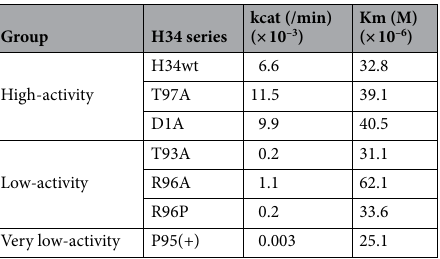
Table 1. Kinetic constants of H34wt and the mutants for FRET-PD1 cleavage reaction.